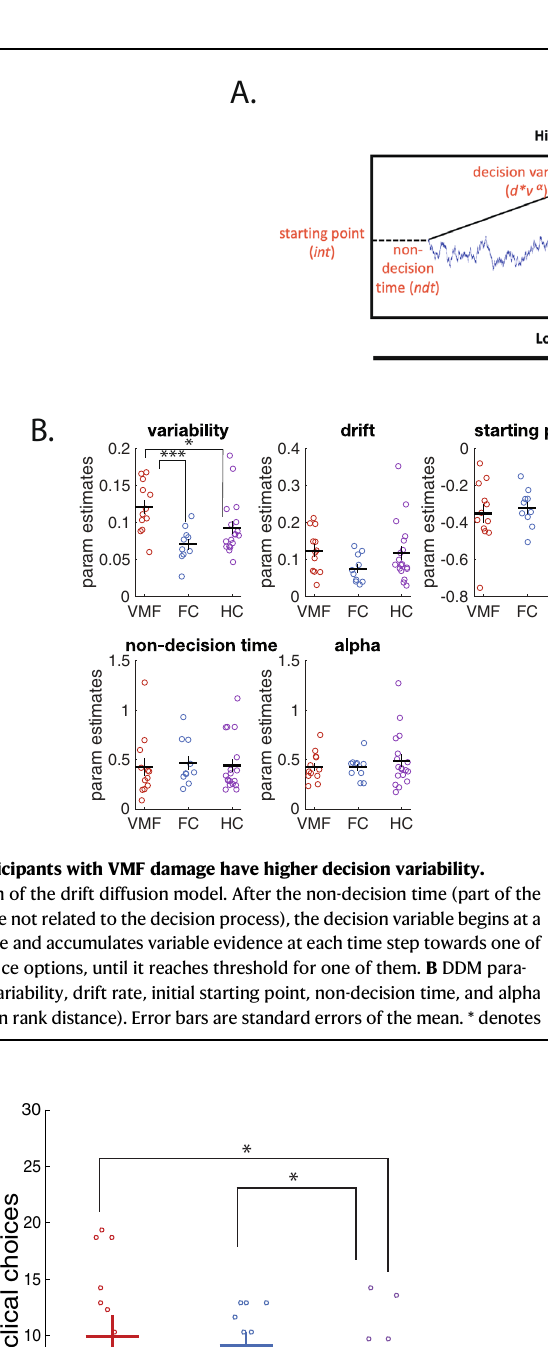
Fig. 3 | Individuals with frontal damage exhibit more choice cycles. Percentage ofchoicecyclesacrossalldomains.Errorbarsarestandarderrorsofthemean.VMF Ventromedial Frontal group; FC Frontal Controls; HC Healthy Controls. * denotes p =0.05 for VMF vs. HC, p =0.02 for FC vs. HC, one-tailed Wilcoxon ranked sum tests. Source data are provided as a Source Data fi le.